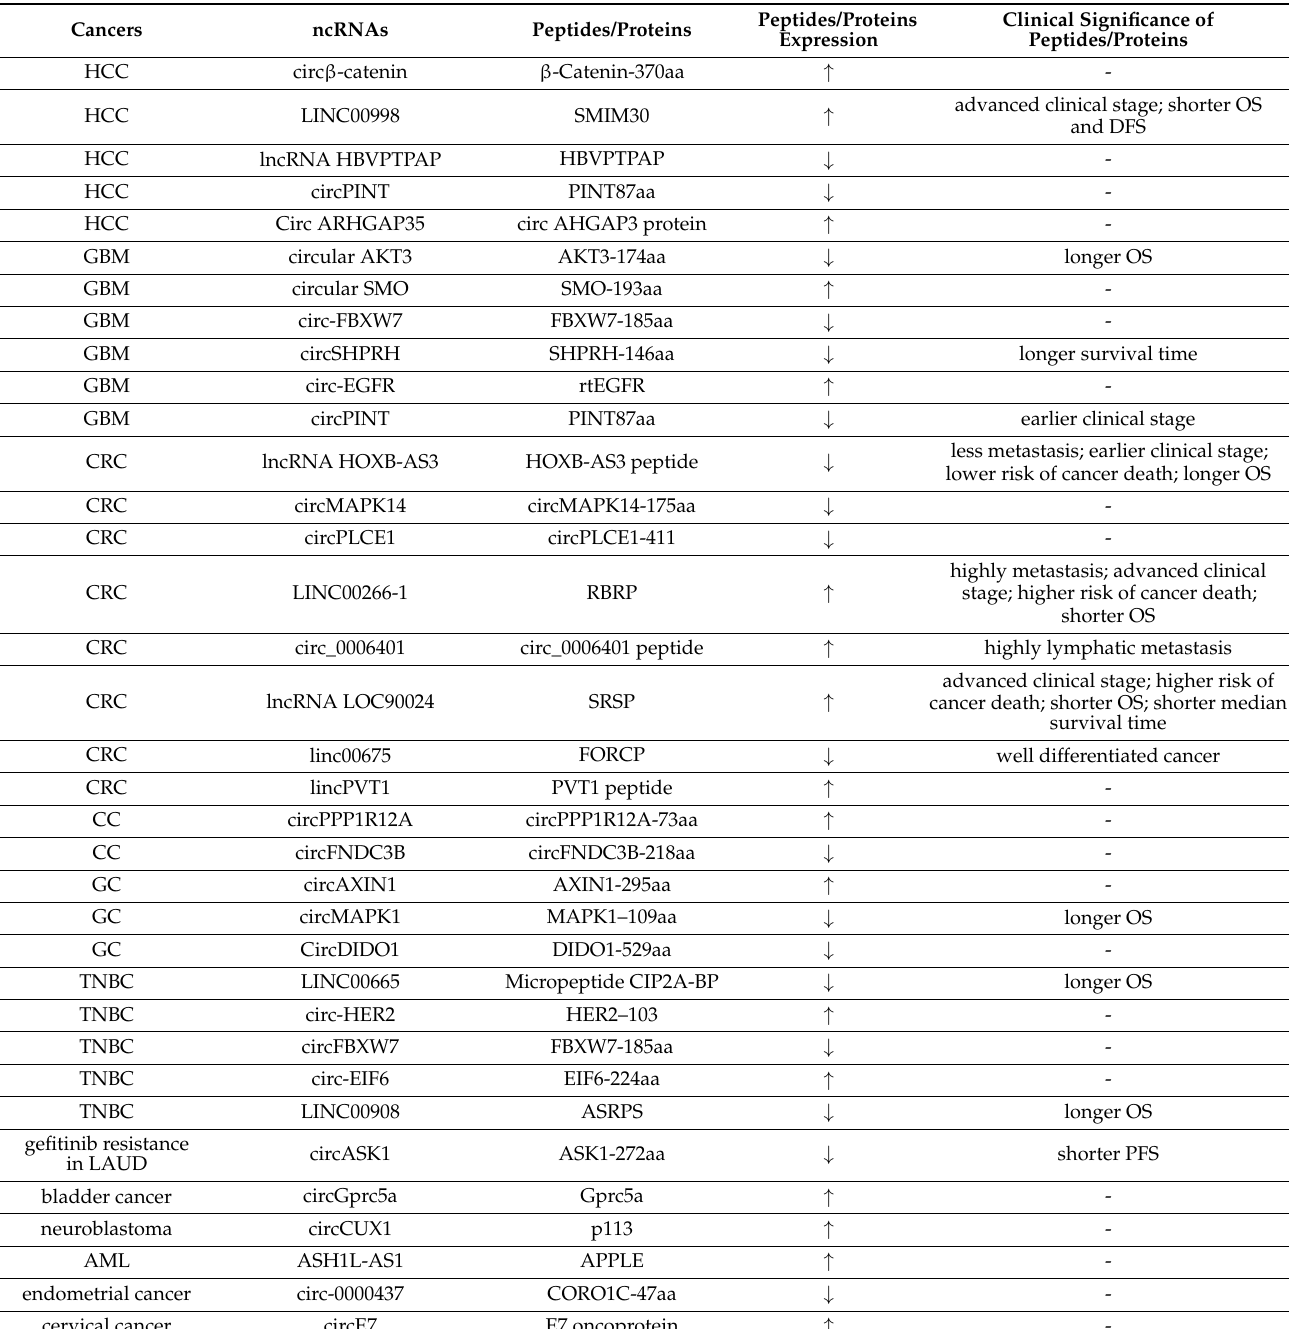
Table 1. Levels and clinical significances of ncRNAs-encoded peptides/proteins in cancers. ↑ means high expression; ↓ means low